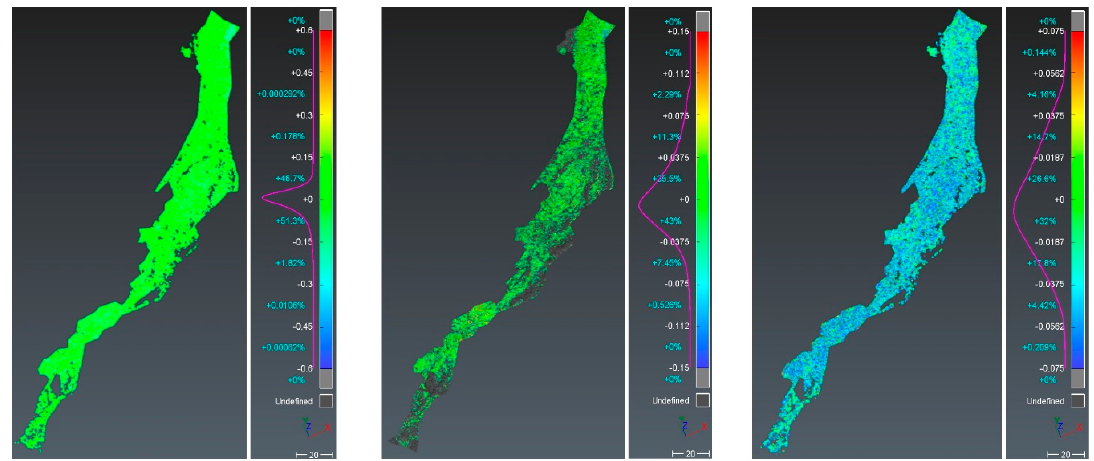
Figure 14. Height comparison of TLS and UAS point clouds in the range up to 600 mm; up to 150 mm; and up to 75 mm.